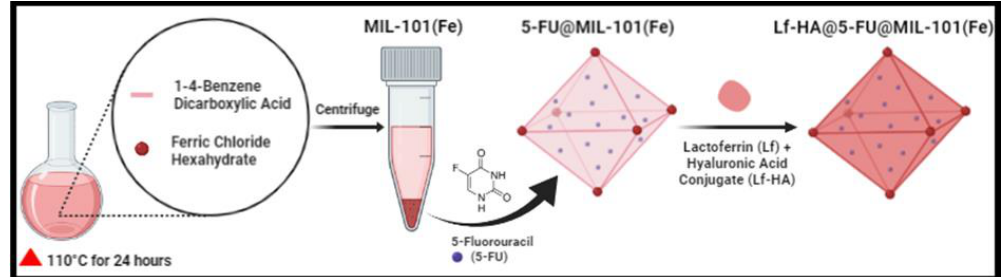
Figure 1. Synthesis scheme of Fe-based MOF (SM-MIL).